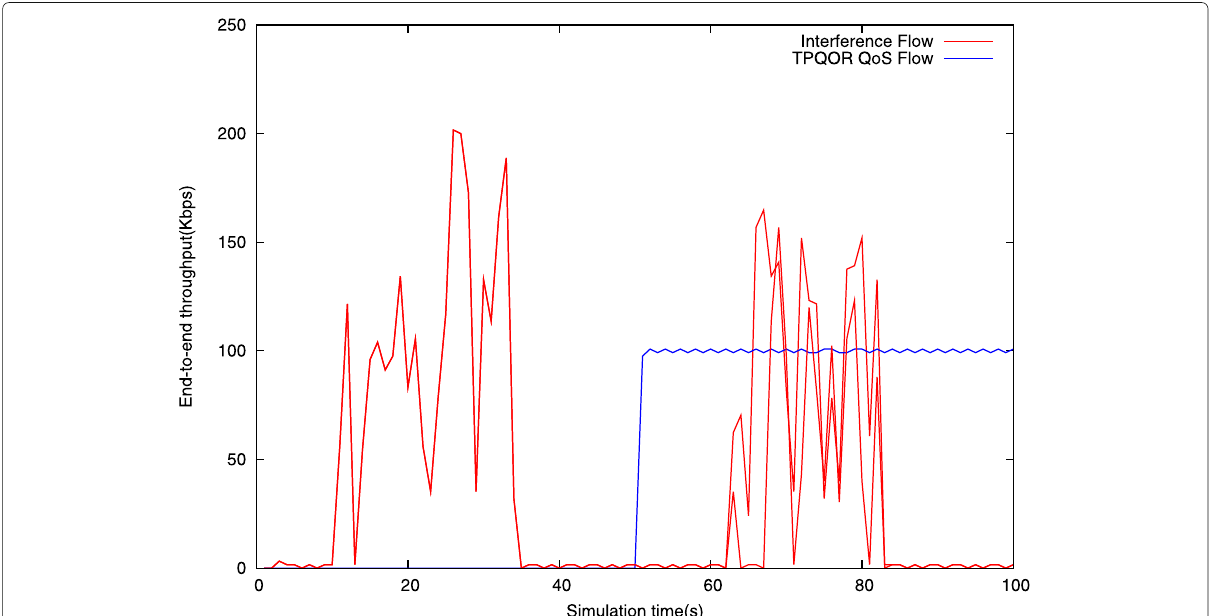
Fig. 9 QoS flow end-to-end throughput of TPQOR as interference flow end-to-end throughput changes